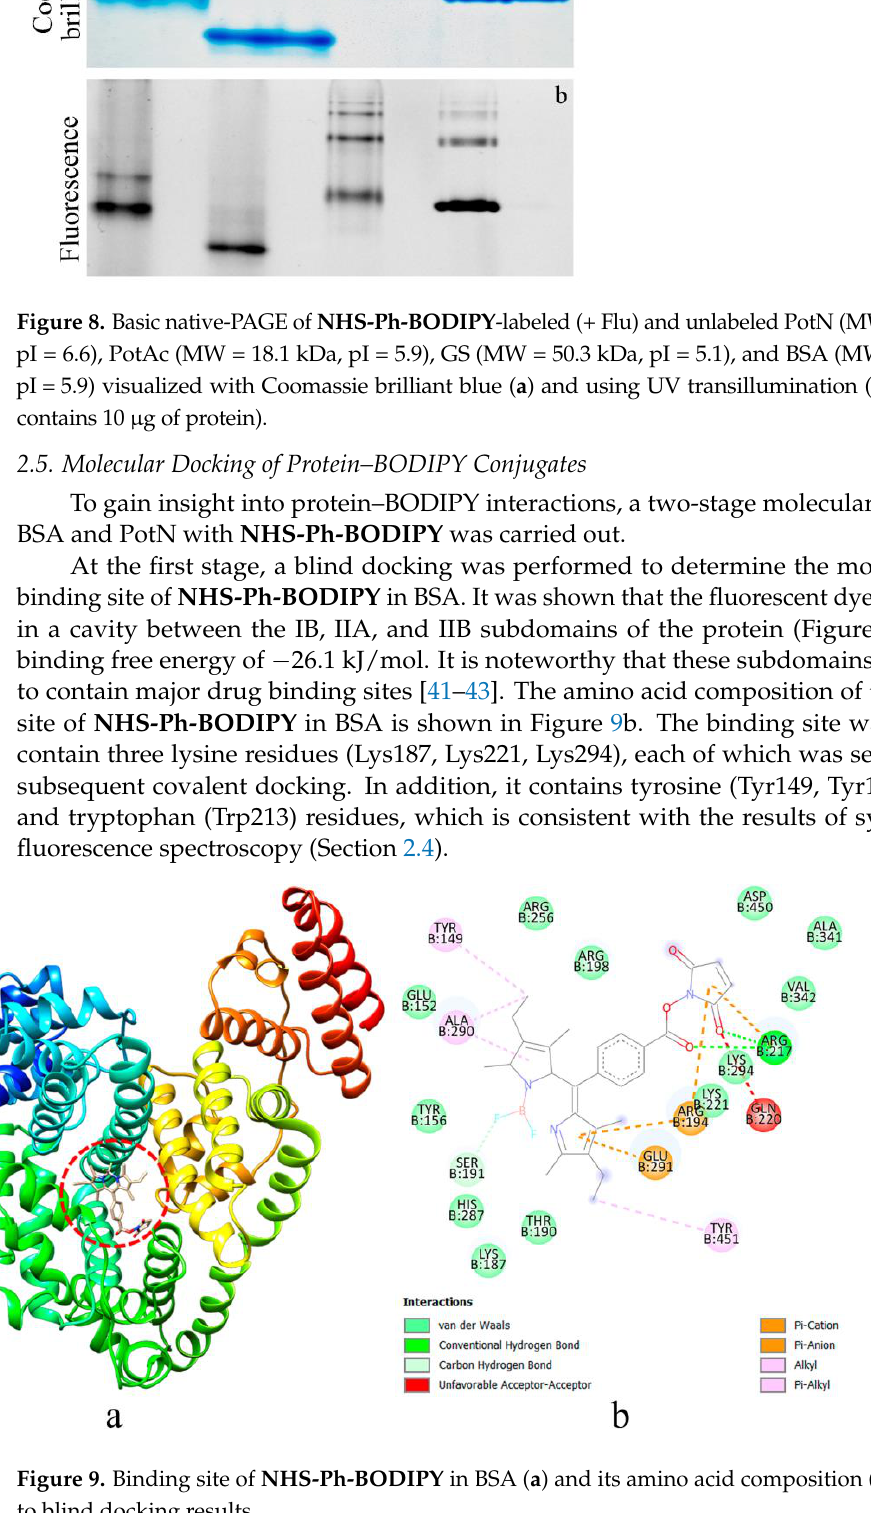
Figure 7. SDS-PAGE of double dilutions of BSA (MW = 66.2 kDa) (left) and PotN (MW = 13.7 kDa) (right) stained with Coomassie brilliant blue ( a , c ) and labeled with NHS-Ph-BODIPY ( b , d ) (each gel contains protein weight marker and unlabeled protein).